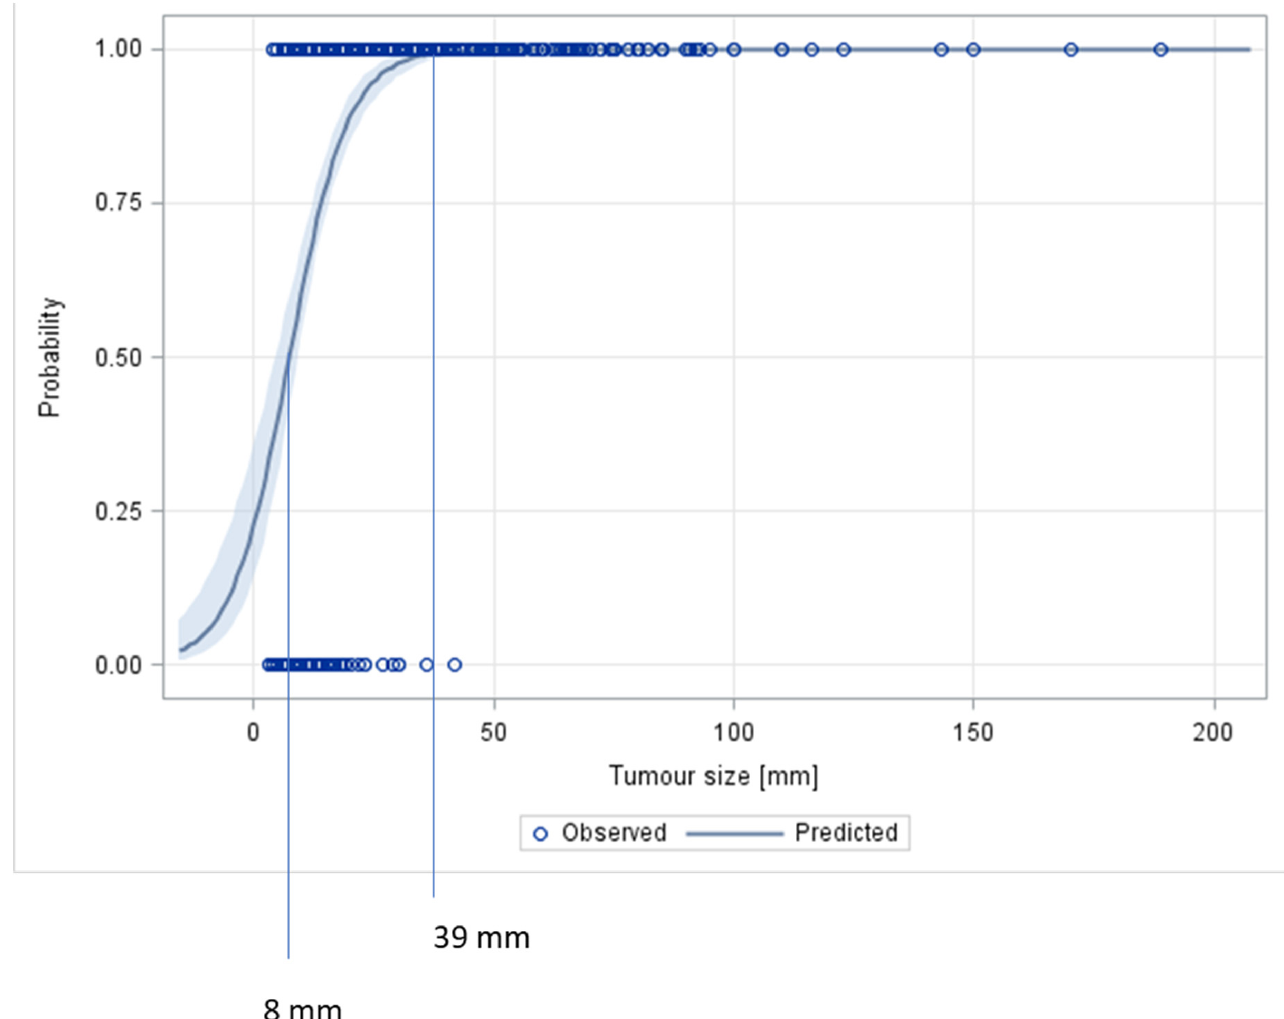
Figure 5. Probability curve for prediction of malignant histology of a testicular neoplasm. The logistic regression curve indicates the probability of a given tumour size to predict malignancy. Shadowed area represents 95% confidence intervals. Neoplasms with a size of ≤ 8 mm involve a 50% probability of malignancy, while tumour sizes of ≥ 25 mm, ≥ 33 mm, and ≥ 39 mm involve probabilities of 95%, 99%, and 100%, respectively.